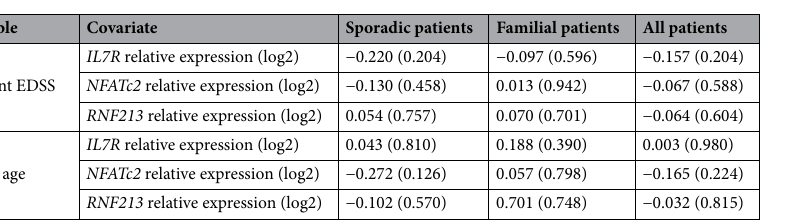
Table 3. Correlation coefficients of relative gene expressions with EDSS and Onset age in patient groups. Bold values denote statistical significance at the p < 0.05 level.